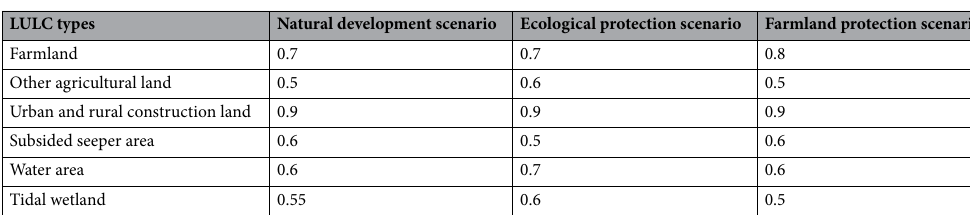
Table 5. The ELAS of LULC types under different